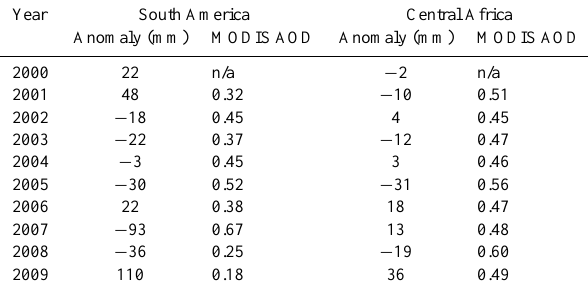
Table 1. May-October Accumulative Rainfall Anomaly (mm) for the 2000–2009 period and September average aerosol optical depth over the study